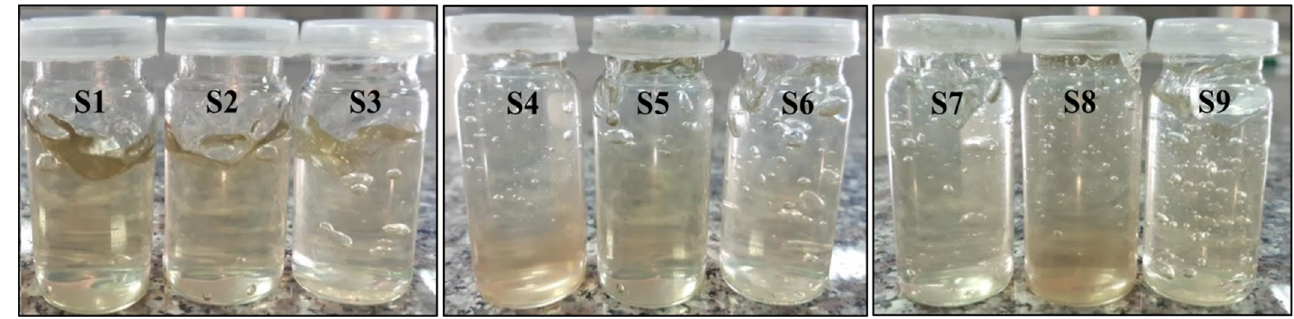
Figure 3. Visual inspection of all samples.